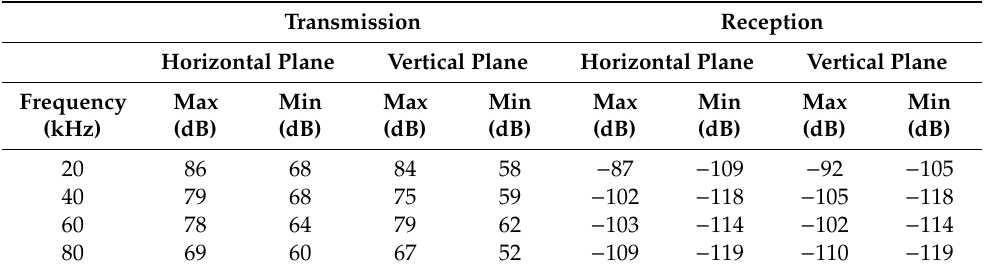
Table 2. Maximum and minimum of dB values obtained from the directivity measurements for the Fibonacci spiral-like transducer. Transmission